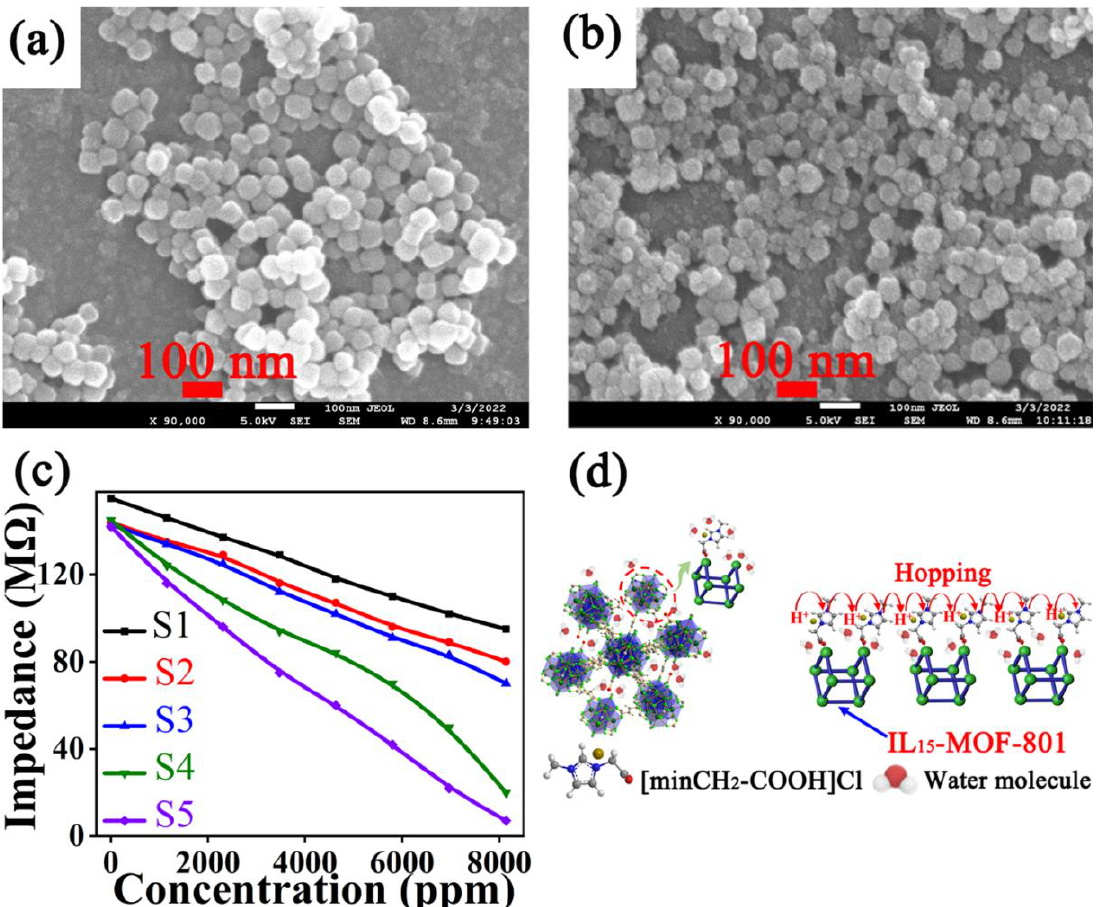
Figure 6. ( a ) SEM image of MOF − 801 (scale: 100 nm). ( b ) SEM image of IL 15 − MOF − 801 (scale: 100 nm). ( c ) Response curves of IL x − MOF − 801 − based humidity sensors to humidity in the range of 0 – 8138 ppmv. ( d ) Crystal structure and humidity − sensing mechanism of IL 15 − MOF − 801 − based humidity sensor. Reproduced with permission from Ref. [84]. Copyright 2022, IEEE.